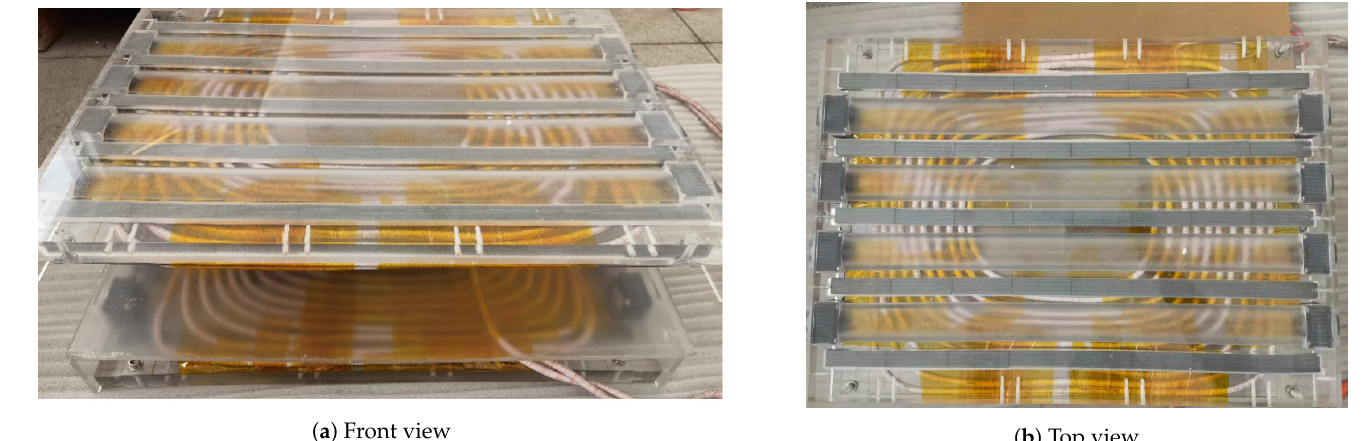
Figure 15. Hardware photo of the magnetic coupling prototype.